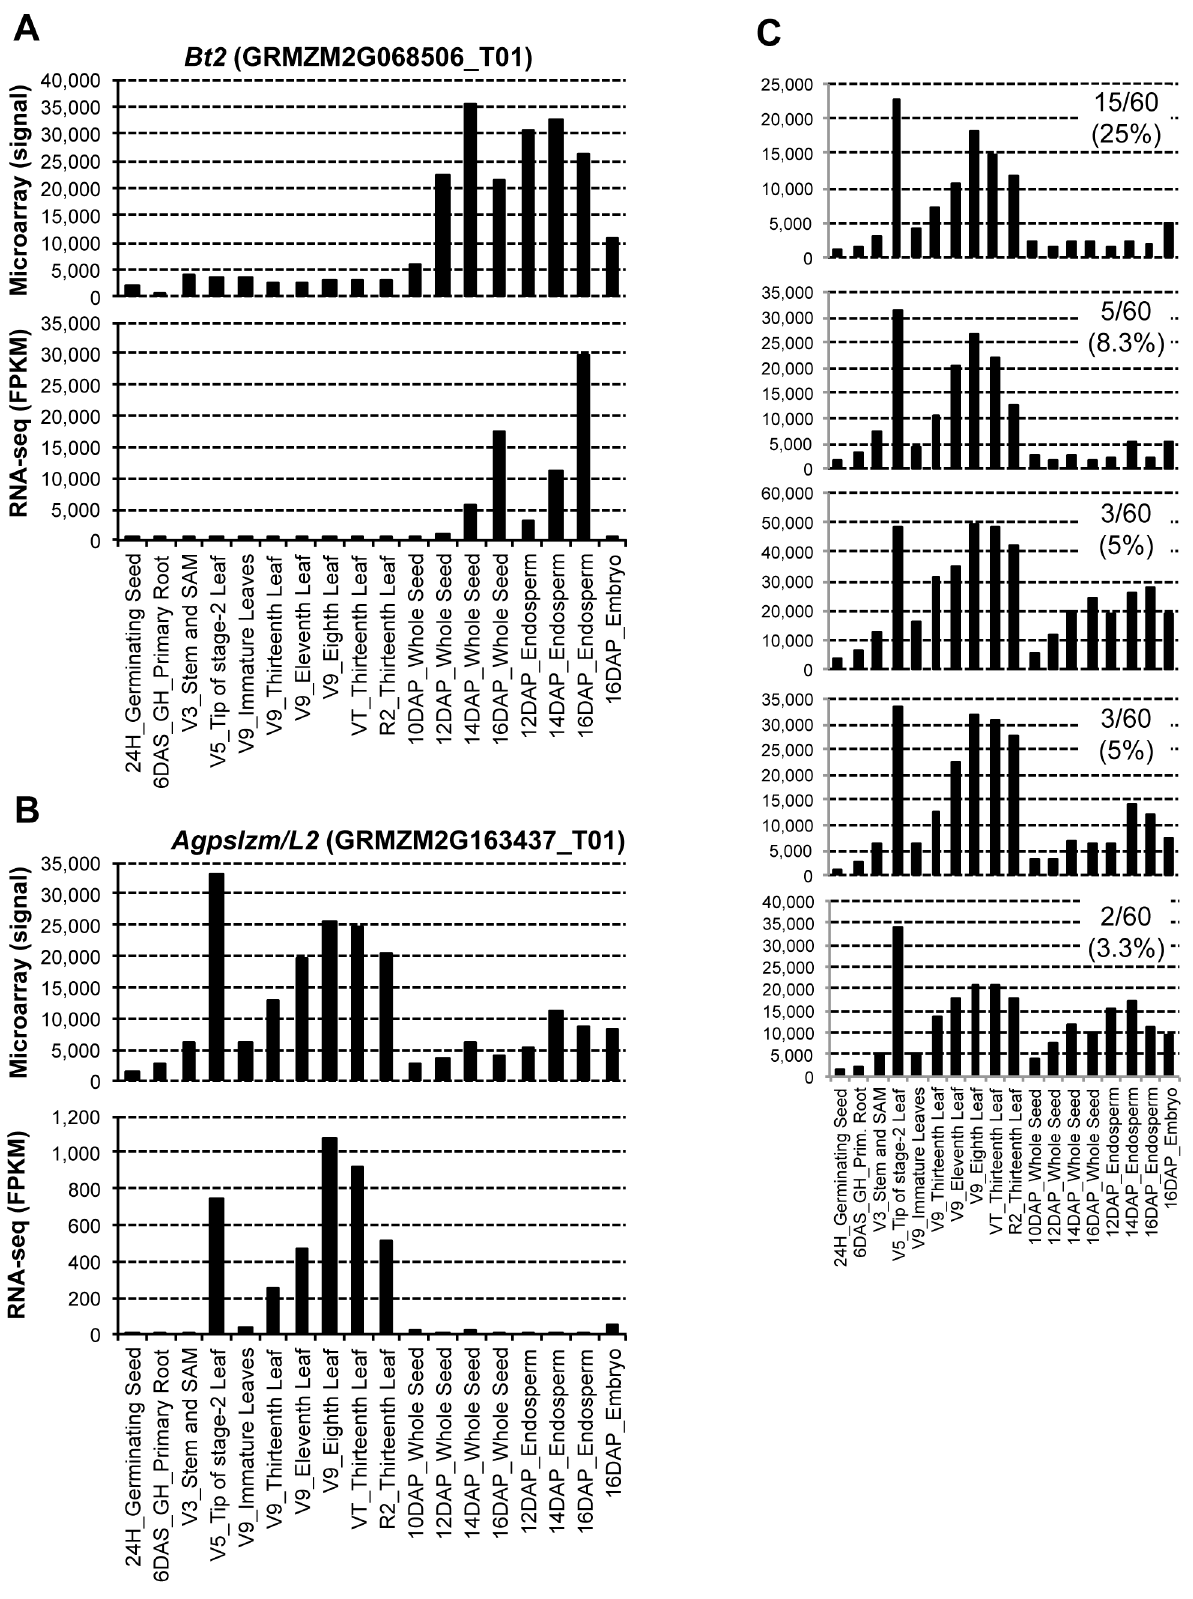
Figure 4. Relative efficiencies of RNA-Seq and microarray in discerning expression of two paralogous genes. A. Expression patterns of endosperm-specific Brittle-2 ( Bt2 ) gene B. Expression patterns of leaf specific Agpslzm/L gene. C. Expression patterns of five individual probes representing Agpslzm/L gene. Sequence differences of each of the 60-mer probes from the paralogous Bt2 , shown as number of mismatches, are in the inset of each graph. doi:10.1371/journal.pone.0061005.g004 PLOS ONE | www.plosone.org